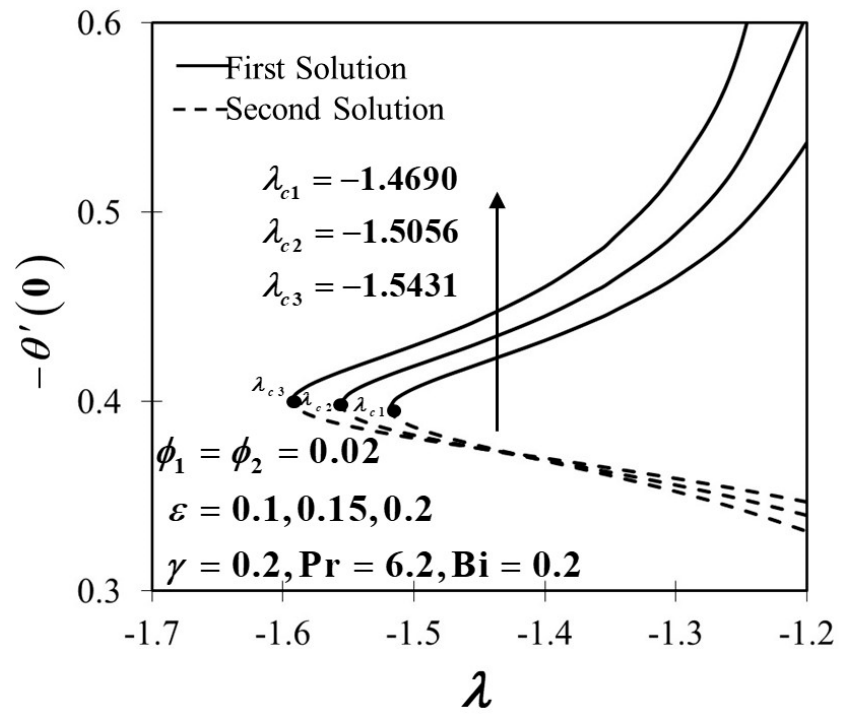
( ) 0 θ′− Figure 11. Variants of − θ (cid:48) ( 0 ) towards λ with ε = Figure 11. Variants of towards λ with